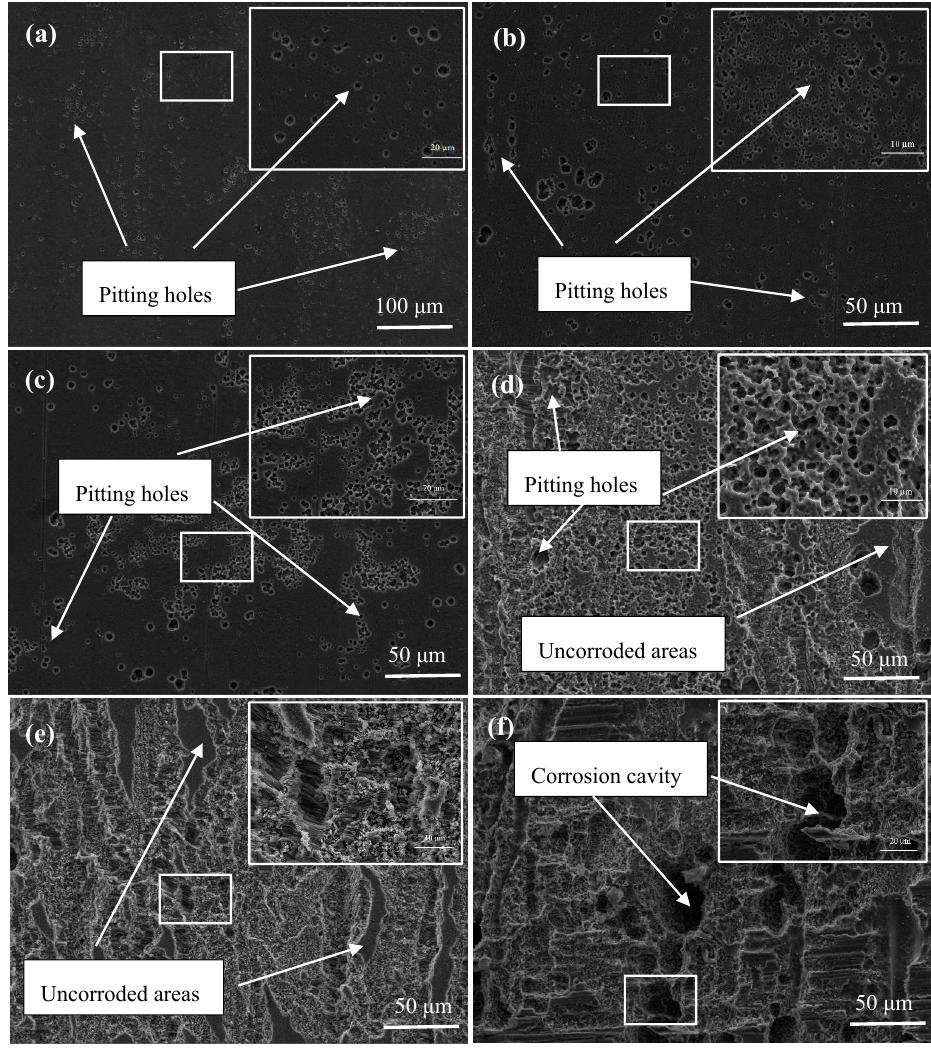
Figure 10. SEM micrographs showing the surfaces of the alloy removing corrosion products after being immersed for ( a ) 5 min, ( b ) 10 min, ( c ) 20 min, ( d ) 40 min, ( e ) 1 h and ( f ) 3 h after immersion in the SBF solution.